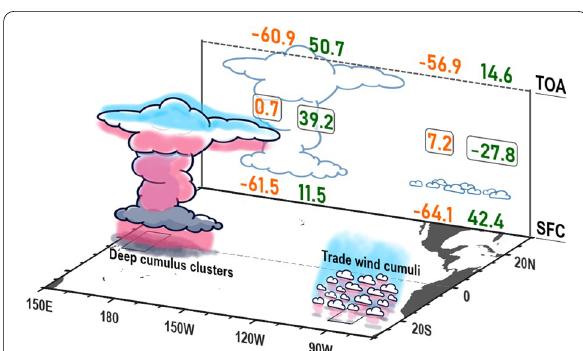
Fig. 8 A schematic depiction of two major cloud types and the estimated CRE from CERES‑EBAF averaged over the Pacific warm pool (5° S–5° N, 155° E–165° E; left) and cold tongue (25° S–15° S, 85° W–95° W; right), respectively. The CRE budgets are divided into SW (orange numbers) and LW (green numbers) components at both TOA and surface. The SWACRE (orange numbers with frame) and LWACRE (green numbers with frame) budgets, taken as the differences between TOA and surface (former–later), are also displayed. Positive and negative CRE represent heating and cooling effects, respectively. The unit of radiation budget is wattm −